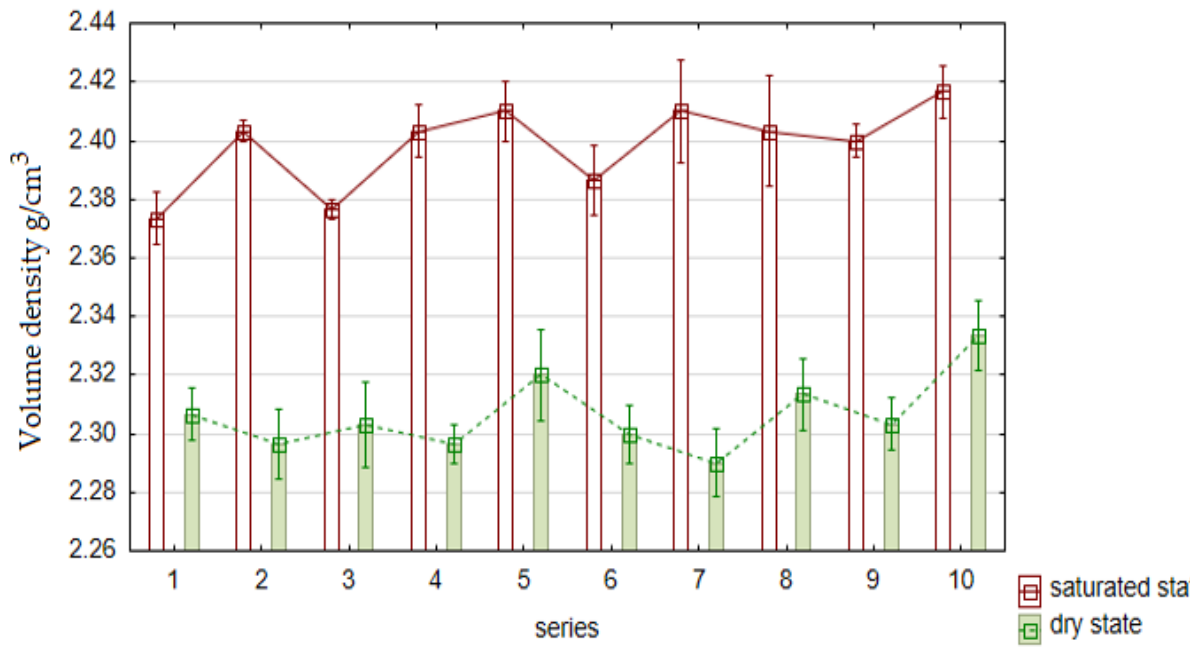
Figure 8. Average results of the volume density of concrete (g/cm 3 ) in the saturated and dry states after 28 days of maturation in comparison with the control series (No. 10).